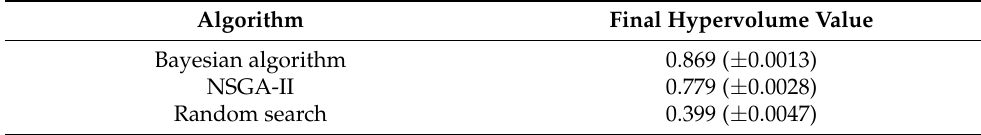
Figure 2. Hypervolume of three algorithms. Table 1. Final constraint evaluation with each algorithm hypervolume value.